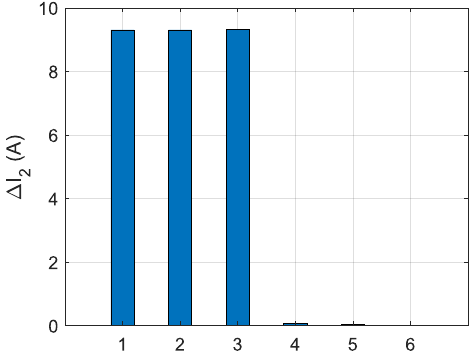
Figure 11. Negative sequence current magnitude.